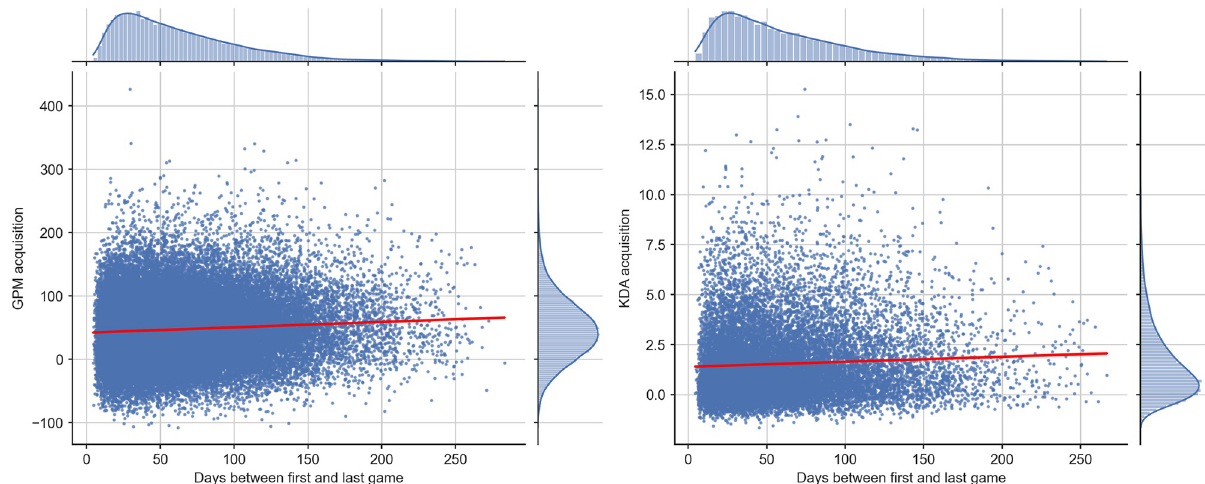
Fig 3. Scatter plots of GPM and KDA against time range in days between first and 95th game respectively, with line of best fit. Axis plots show distributions of respective axis variables.